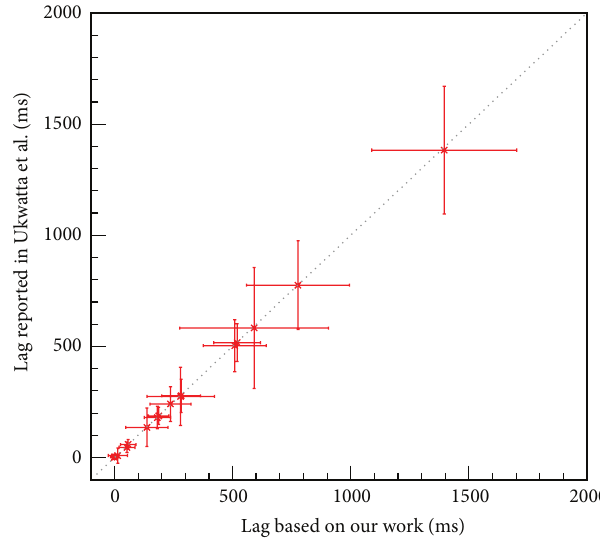
Figure1:TherelationshipbetweenthelagreportedinUkwattaetal., 2010, and the lag based on our work for common GRBs. The dotted line shows 𝑦 = 𝑥